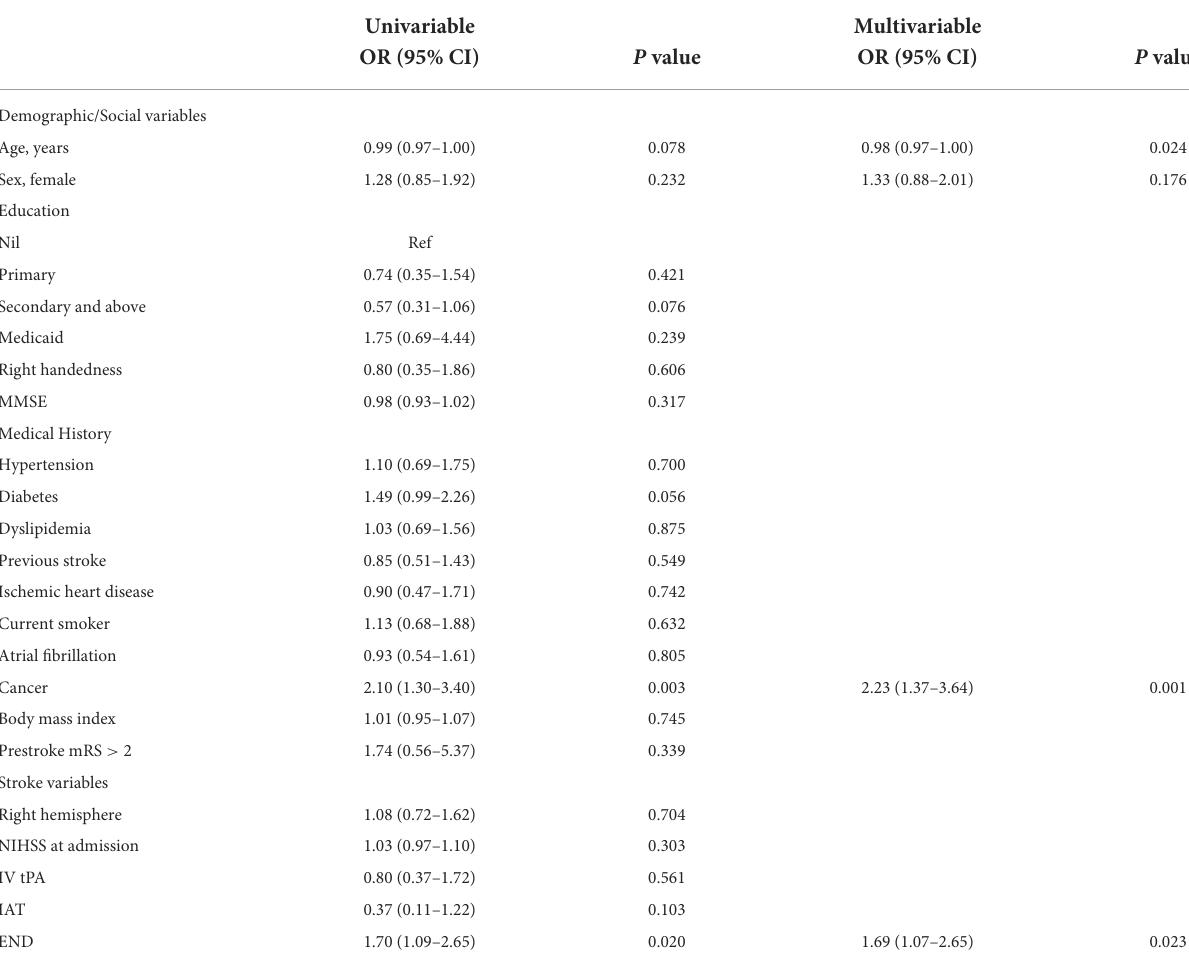
TABLE 2 Predictors for PHQ-9 positive.